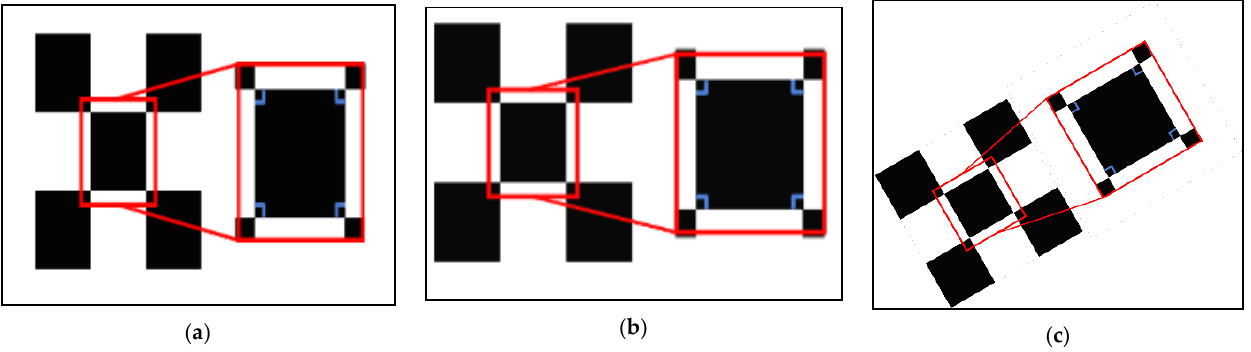
Figure 6. Angles of a square when an angle error has occurred on a single axis in an image based on an x-y plane, ( a ) x -axis of the image, ( b ) y -axis of the image, and ( c ) z -axis of the image. As revealed in Figure 7, not all angles of a square are 90 degrees if a rotation occurs on at least two axes. In this case, all angles of the square vary depending on the rotation axis and angle, and it becomes a simple square. The included angles are calculated using